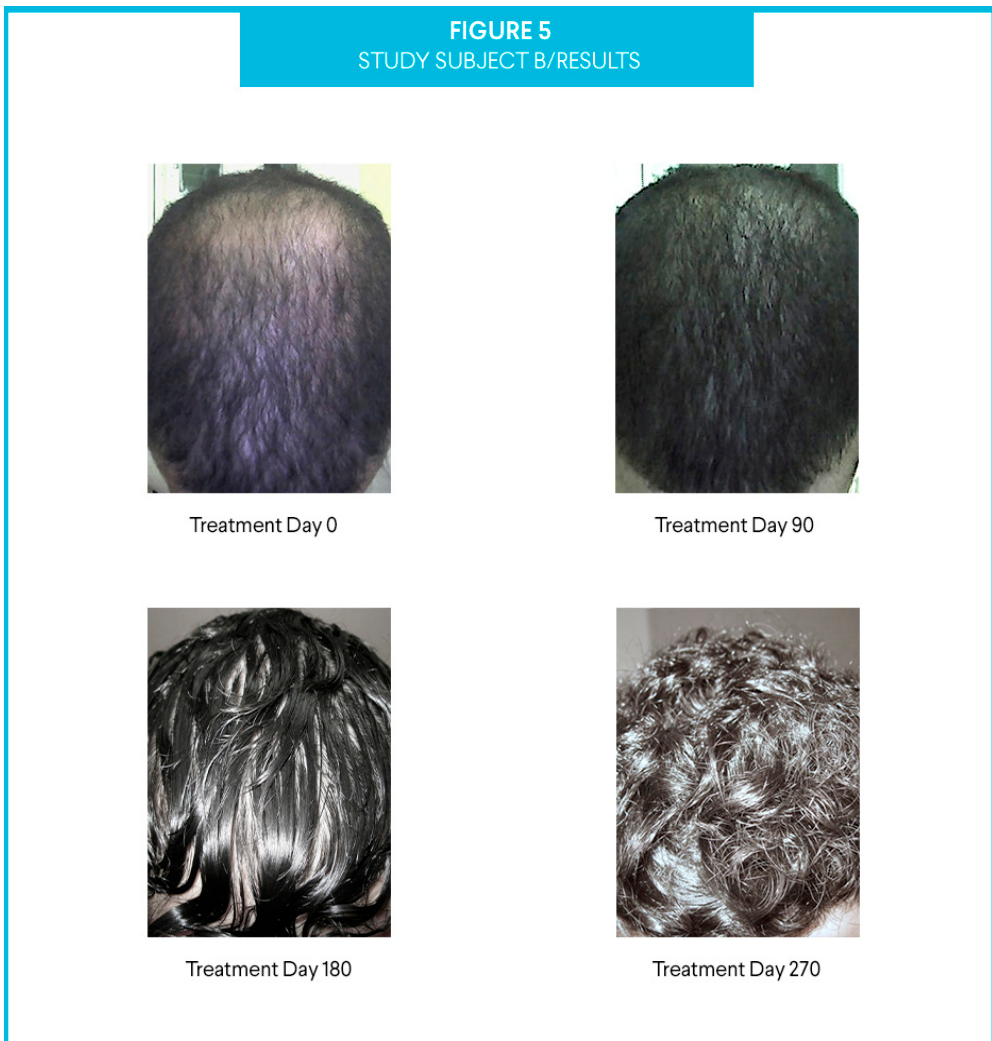
Figure 5. Subject B / hair caliber / 90-day time intervals.